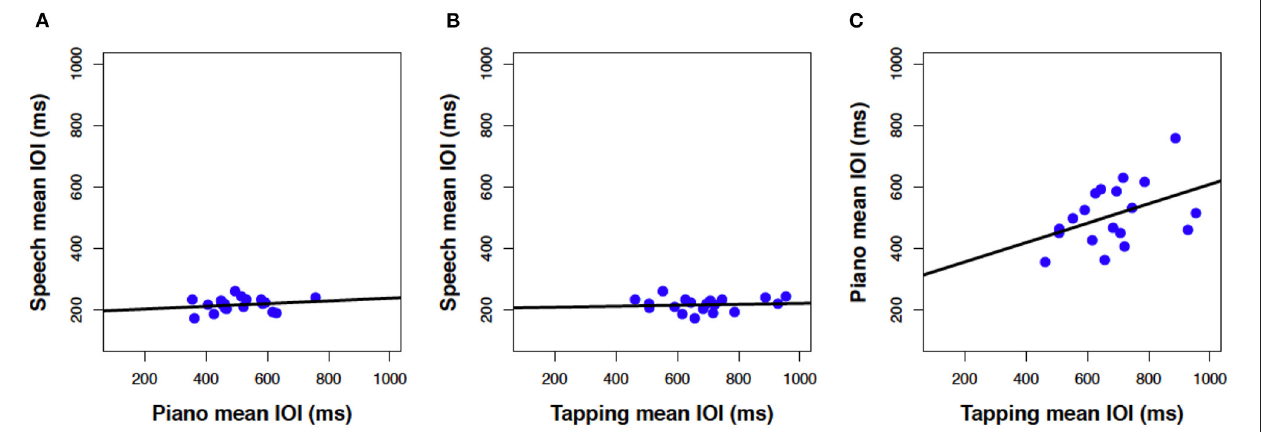
FIGURE 2 | Scatterplots relating mean IOI (spontaneous rate) across piano and speech production (A) , rhythmic tapping and speech production (B) , and piano and rhythmic tapping production (C) . Lines reflect best-fitting linear regressions; each dot = one participant’s mean IOI averaged across all trials for a given task ( N = 19 in each